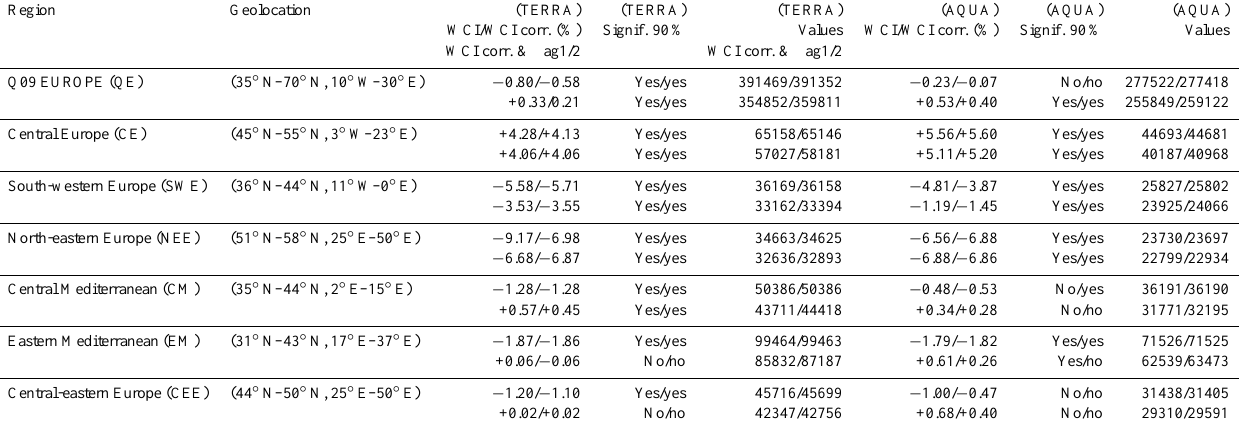
Table 1. Regions of interest defined from the WCI with their corresponding geolocation, the average WCI per region for the initial dataset, for the corrected dataset using the ± 1000% limit and for the corrected dataset using the ± 1000% limit and additional corrections using flag1 and flag2. The statistical significance at the 90% confidence level and the number of values included in the calculations are also given. Region Geolocation (TERRA) (TERRA) (TERRA) (AQUA) (AQUA) (AQUA) WCI/WCI corr. (%) Signif. 90% Values WCI/WCI corr. (%) Signif. 90% Values WCI corr. &